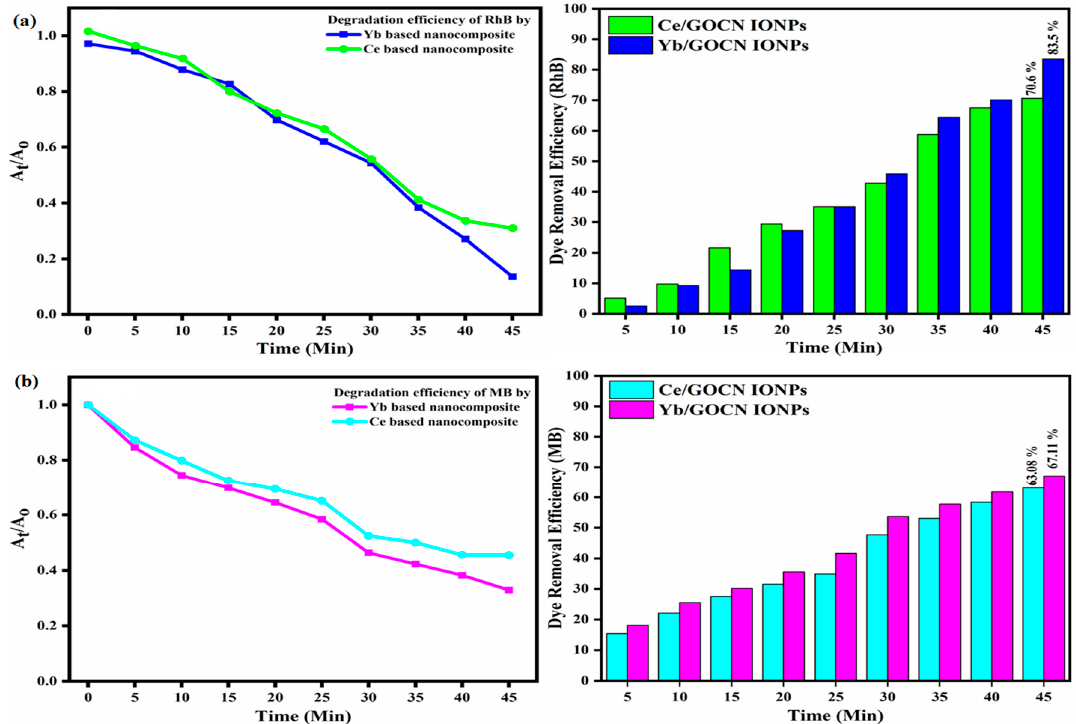
Figure 7. Efficiency comparison of ( a ) RhB dye and ( b ) MB dye by using Ce- and Yb-based nanocomposites.